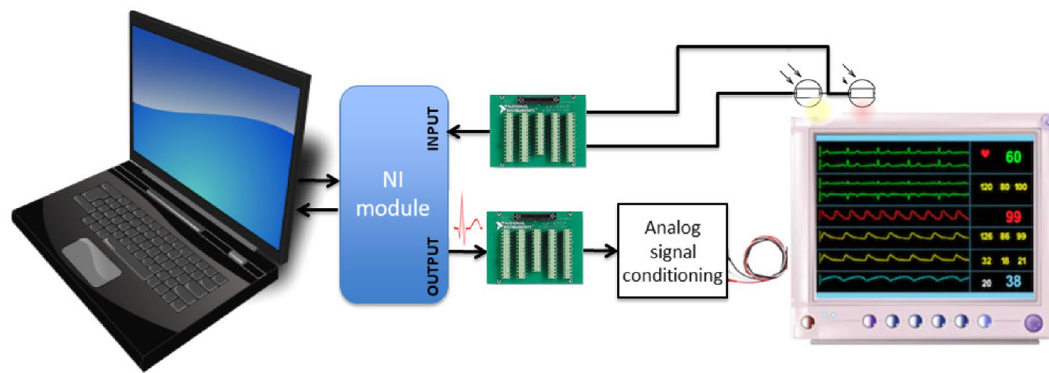
Figure 2. Proposed test-bench. Recorded ECG signals were converted from digital to analog, conditioned, scaled and presented as input to a Philips IntelliVue MP20 monitor. Alarms generated by the monitor were captured using a photoresistor sensor fixed on the alarm activity LED of the monitor.